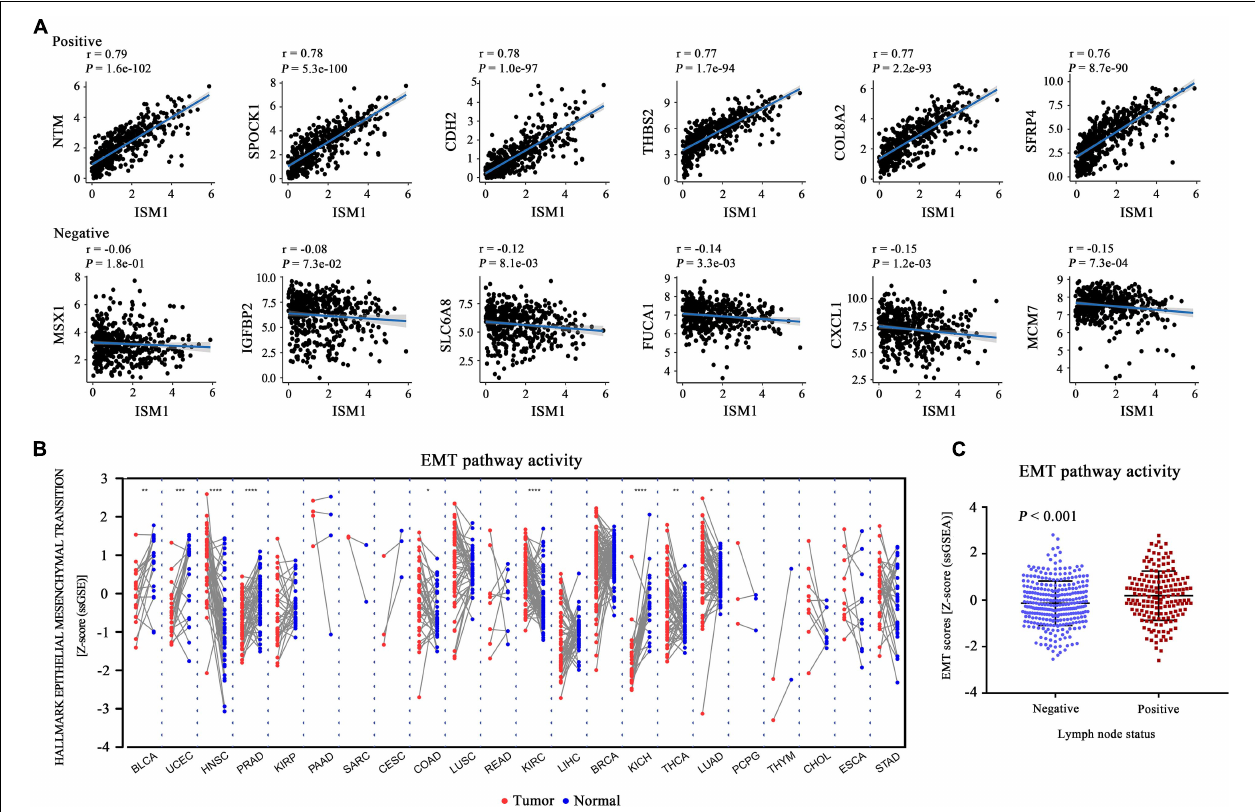
FIGURE 5 | Epithelial-mesenchymal transition (EMT) activity score in all cancer types. (A) Pearson’s correlation between ISM1 and genes in the EMT pathway was calculated, and the top six positively and negatively correlated genes are shown. (B) The pathway activity score for EMT was calculated and compared across 22 cancers from TCGA between tumor tissues (red dot) and paired normal tissues (blue dot). (C) EMT activity score for 300 lymph node non-involvement tissues (41 normal tissues and 259 negative lymph node tissues) and 173 lymph node involvement tissues. * P < 0.05; ** P < 0.01; *** P <